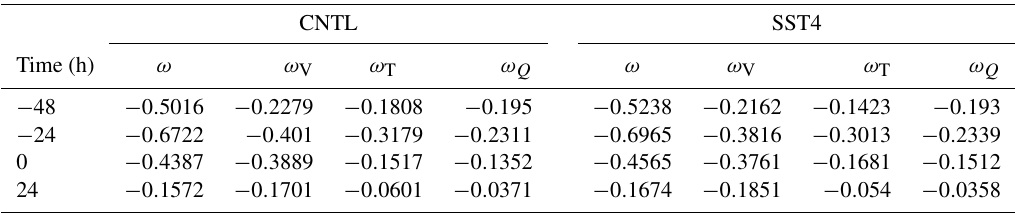
Table 2. Maximum values of ascent (Pas − 1 ) at 700hPa directly from the model ( ω ) and attributed to vorticity advection ( ω V ), thermal advection ( ω T ), and diabatic heating ( ω Q ) in the CNTL composite mean and the SST4 composite mean at different offset times. CNTL